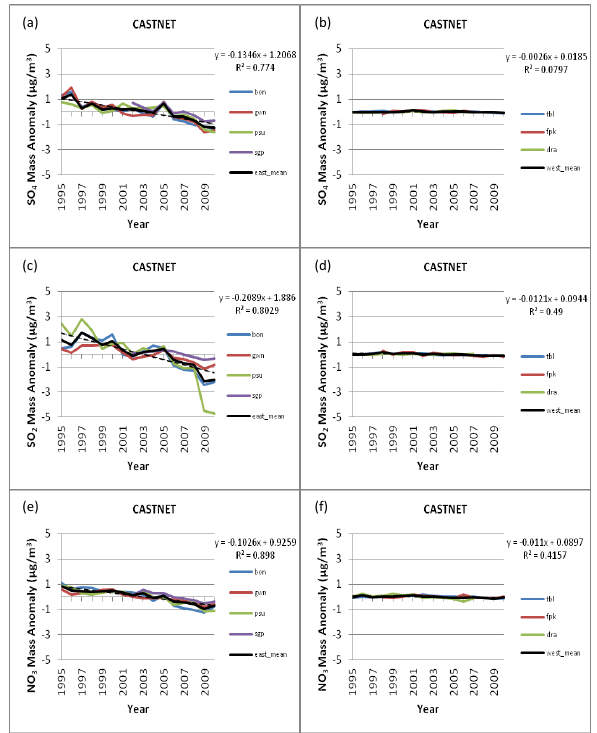
Figure 7: Annual anomalies of SO 4 (first row), SO 2 (second row) and NO 3 (third row) from 4 Fig. 7. Annual anomalies of SO 4 (top row), SO 2 (bottom row) and CASTNET for each site (colored line) and the network mean (solid black line) together with 5 NO 3 (third row) from CASTNET for each site (colored line) and the LSF (dash black line) to the network mean. The best-fit equation and coefficient of 6 the network mean (solid black line) together with the LSF (dash determination (R 2 ) are given at right in each panel. The left column represent eastern US 7 black line) to the network mean. The best-fit equation and coeffi- while the right column represent western US 8 cient of determination ( R 2 ) are given at right in each panel. The left column represents eastern US while the right column represents western US.